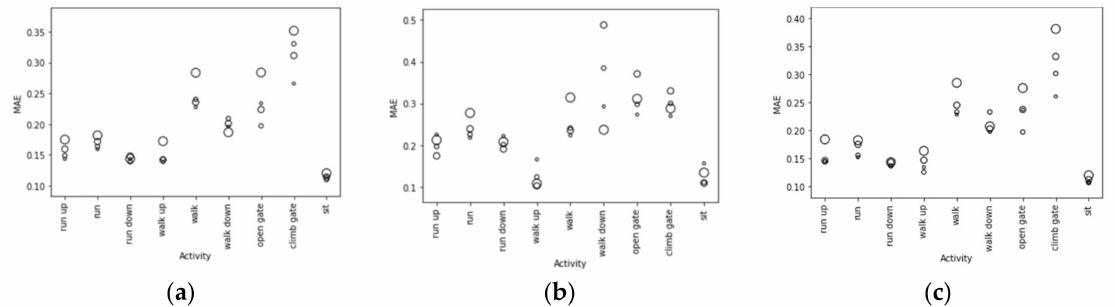
Figure 7. Training Loss, MAE, for ( a ) Accelerometer, ( b ) ECG and ( c ) combined ECG and accelerometer, epoch = 100, circle radius set by data window width (64, 128, 256,